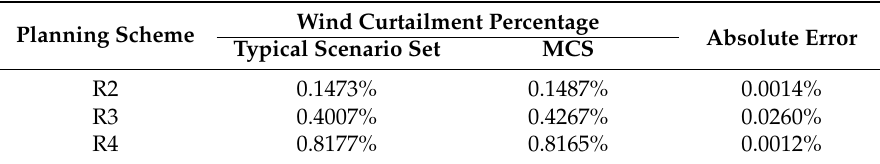
Table 3. Comparison results for wind curtailment